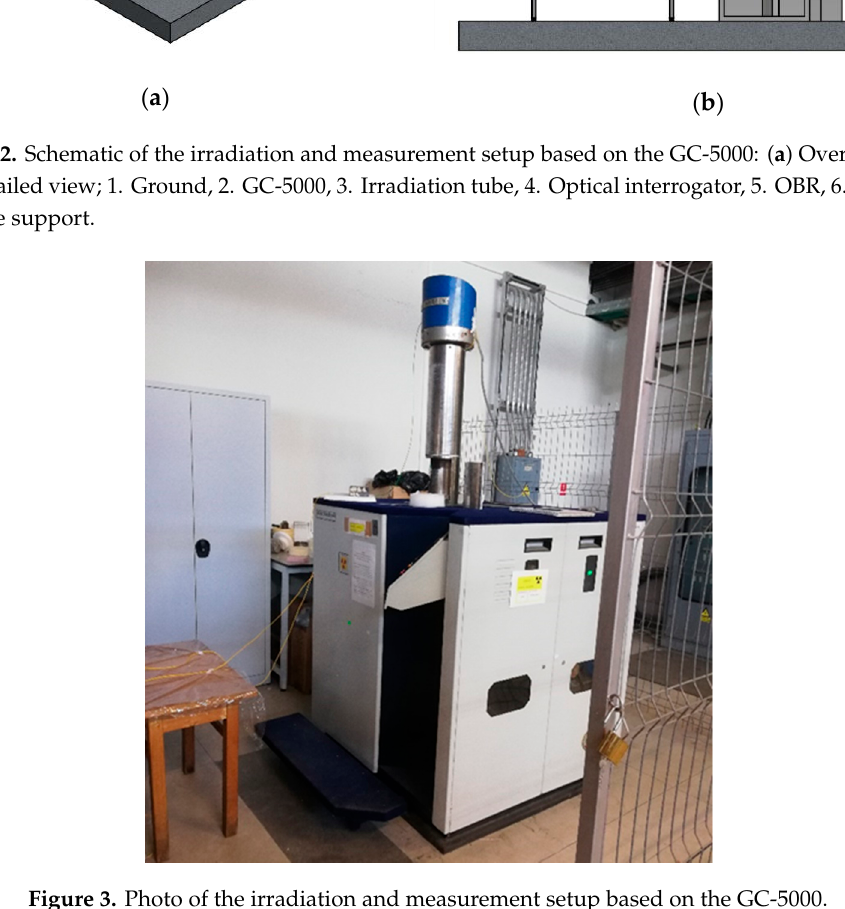
Figure 3. Photo of the irradiation and measurement setup based on the GC-5000.